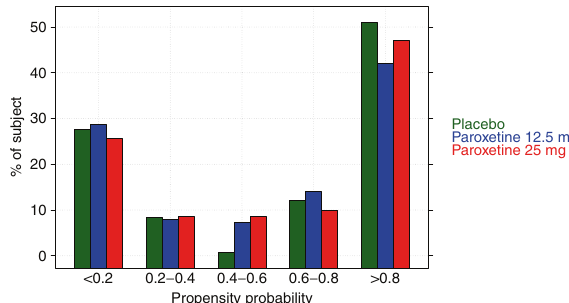
Fig. 2 Propensity probability. Distribution of the propensity prob- ability to a placebo effect by treatment.